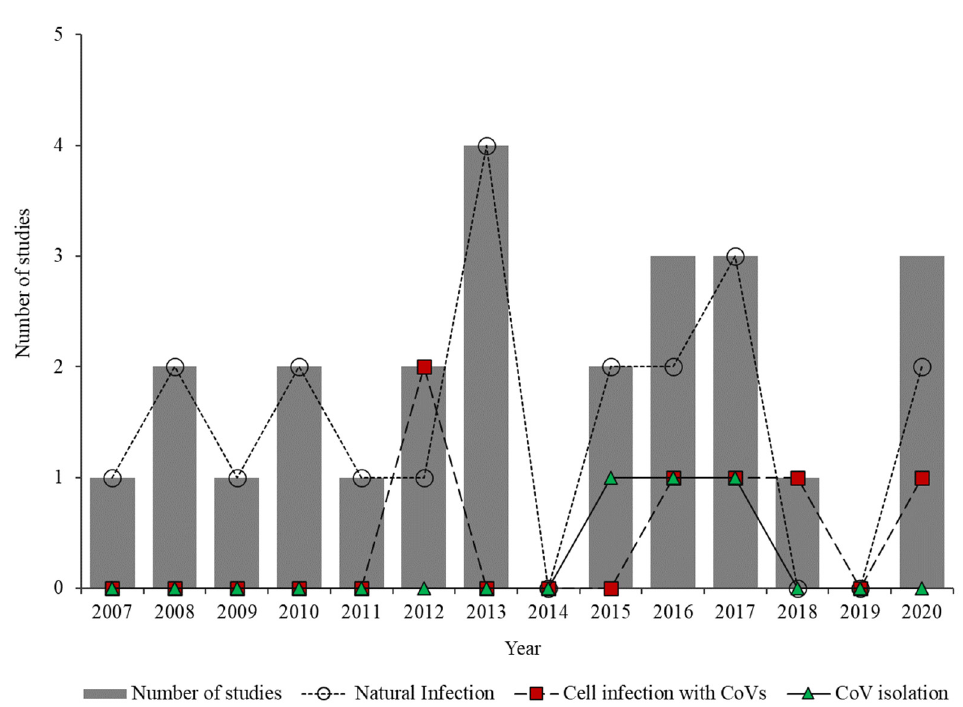
Figure 2. Number of studies examining natural infection, experimental coronavirus infection in bat cells, and coronavirus isolation over time. Table 1. Bat species in which natural coronavirus infection has been explored in the Americas. Bat